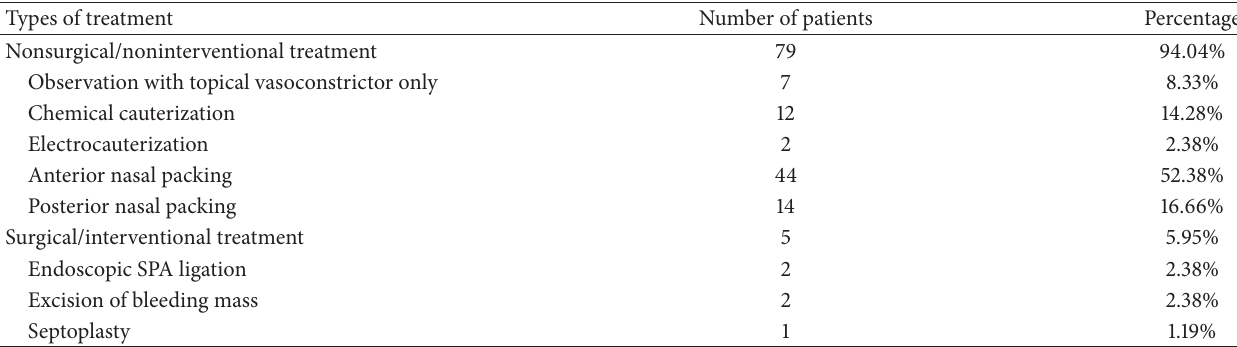
Table 2: Treatment methods for patients with epistaxis ( 𝑛 = 84